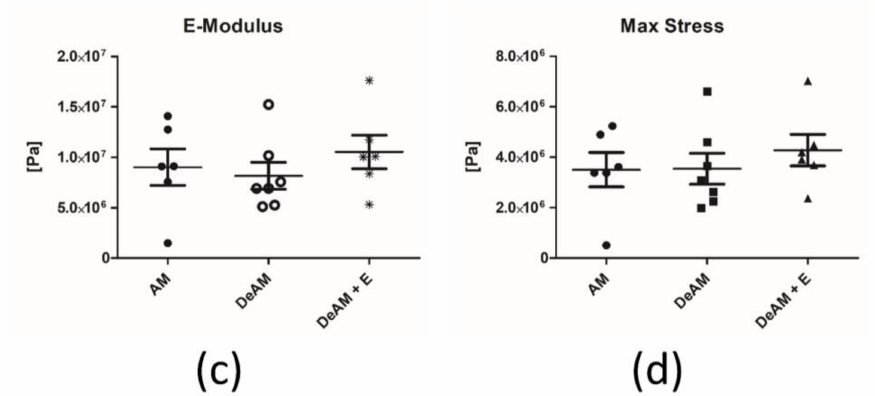
Figure 3. Determination of mechanical properties of the amniotic membrane (AM), the DeAM and the DeAM + E by the uniaxial pulling test. ( a ) Setup of horizontal pulling test, ( b ) Representative stress-strain curve, ( c ) single values E-modulus and ( d ) single values maximum stress resistance. n ≥ 6.